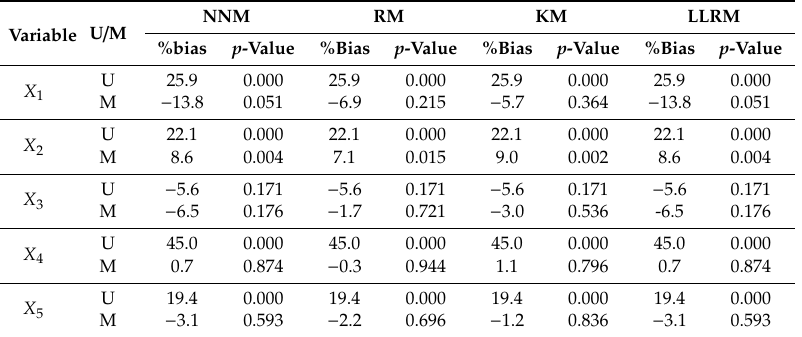
Table 1. Variable balance between treated and control groups, before and after matching.